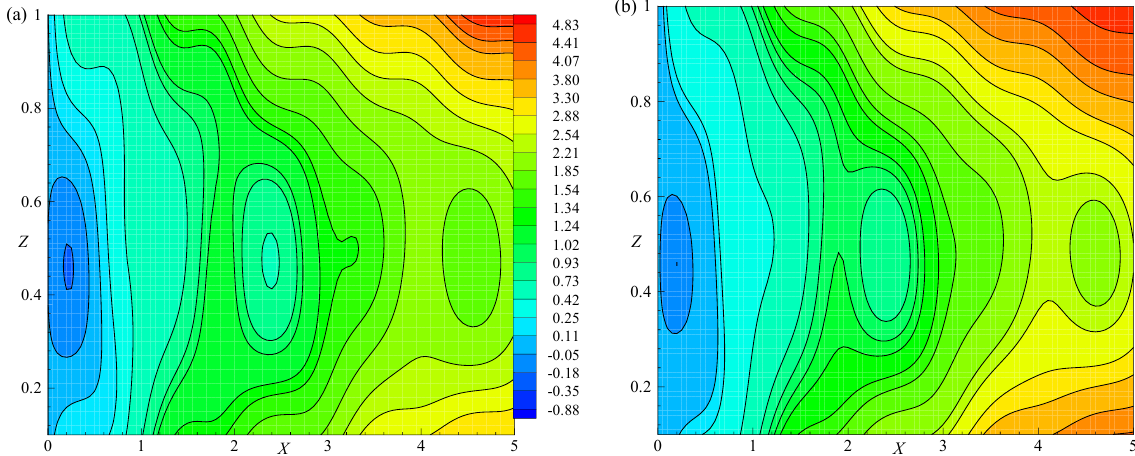
Figure 18. Heatlines of χ = 0.3 ( a ) and 0.4 ( b ) for Le = 0.04, ψ = − 0.03, t = 0.8, R = 3 R co